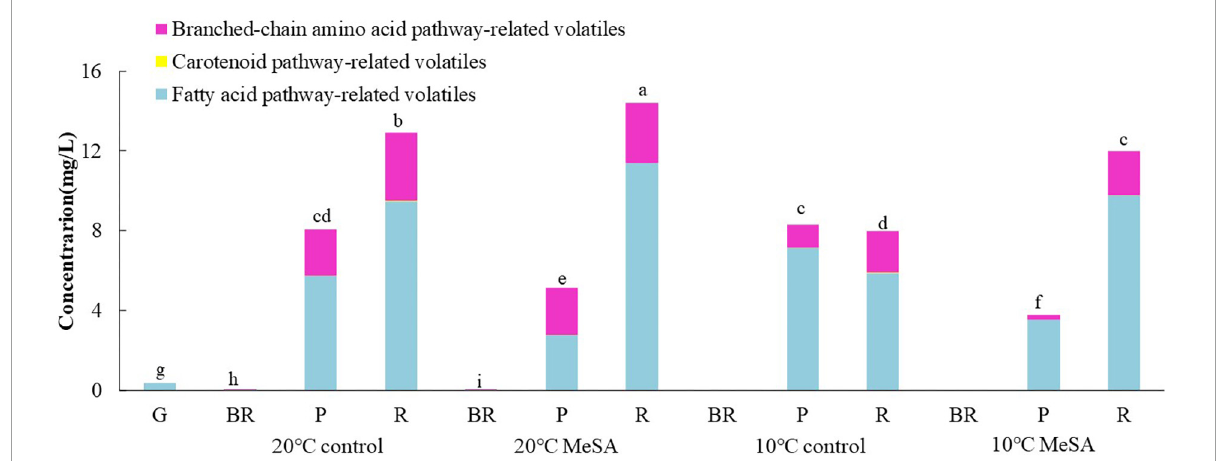
FIGURE2 Effects of methyl salicylate (MeSA) pre-treatment on the levels of fatty acid pathway-, carotenoid pathway-, and branched-chain amino acid pathway-related volatiles in tomato fruits stored at low temperature. Data are expressed as mean ± SD ( n = 3), repeated measures one-way ANOVA followed by Duncan’s multiple range test (DMRT). Data marked with the same letter were no significant difference at p < 0.05.